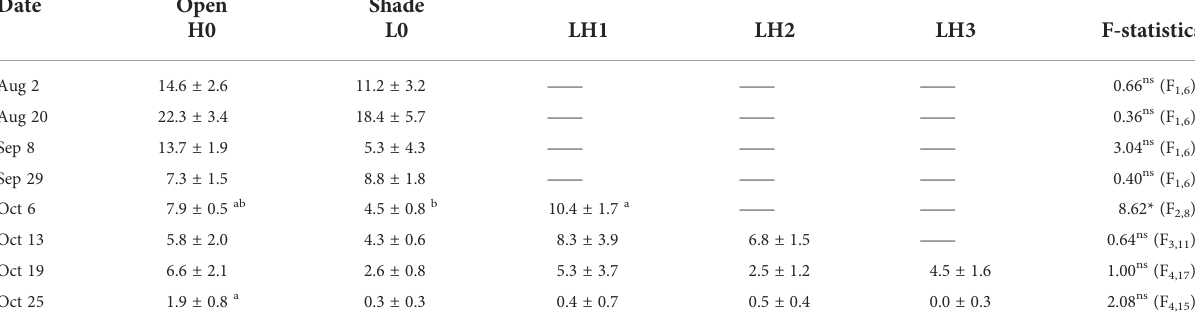
TABLE 4 Seasonal change in dry-mass based leaf starch content (mg g -1 ) in leaves offullmoon maple seedlings grown under different light